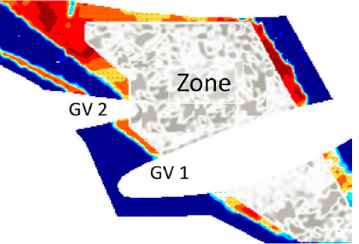
Figure 7. Schematic diagram of the investigated region (the grey Zone) of the dissipation loss φ S .